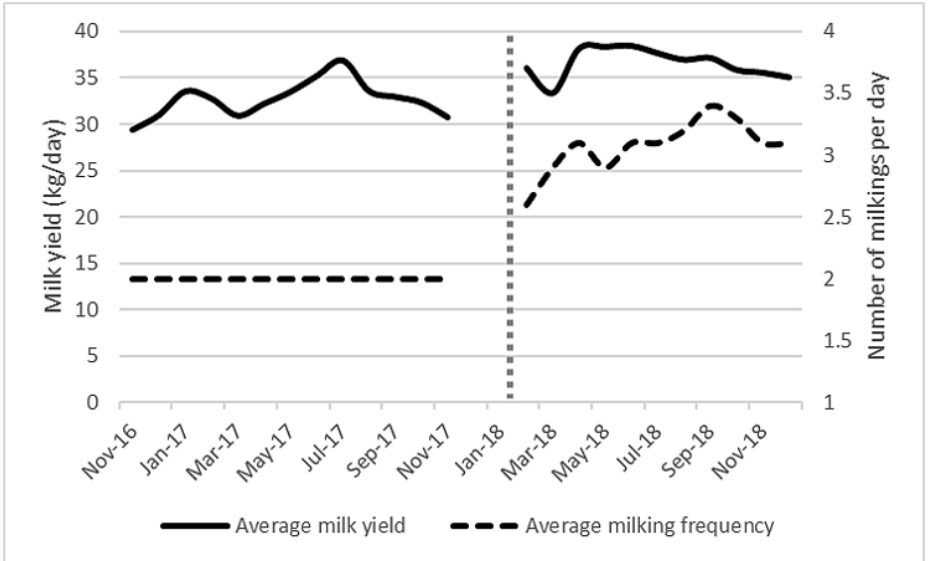
Figure 3. Average milk yield (kg/day) and average milking frequency (milking sessions/day) from November 2016 to December 2018 for all (101 ± 6) lactating cows on the study farm. Vertical dotted line represents AMS installation.